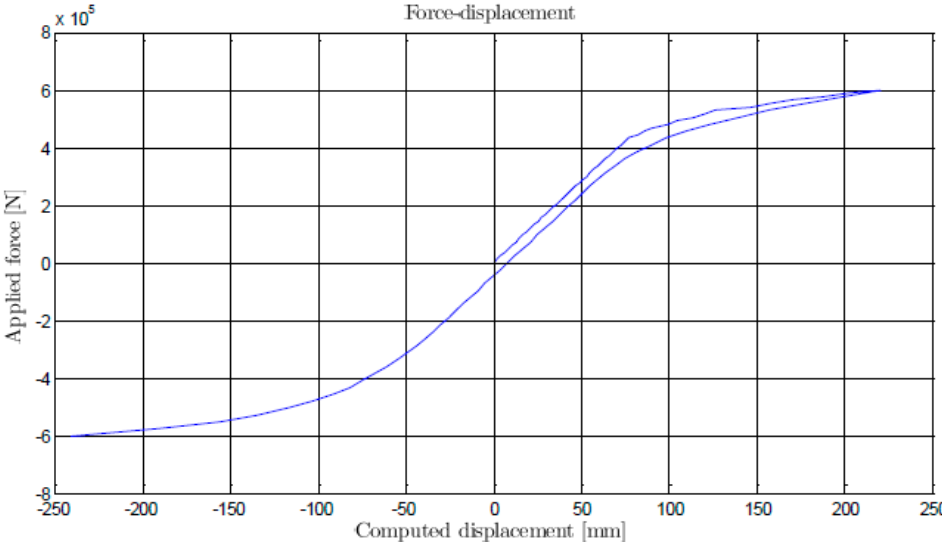
Figure 1: The curve “applied force – computed displacement” (ANSYS analysis under cyclic